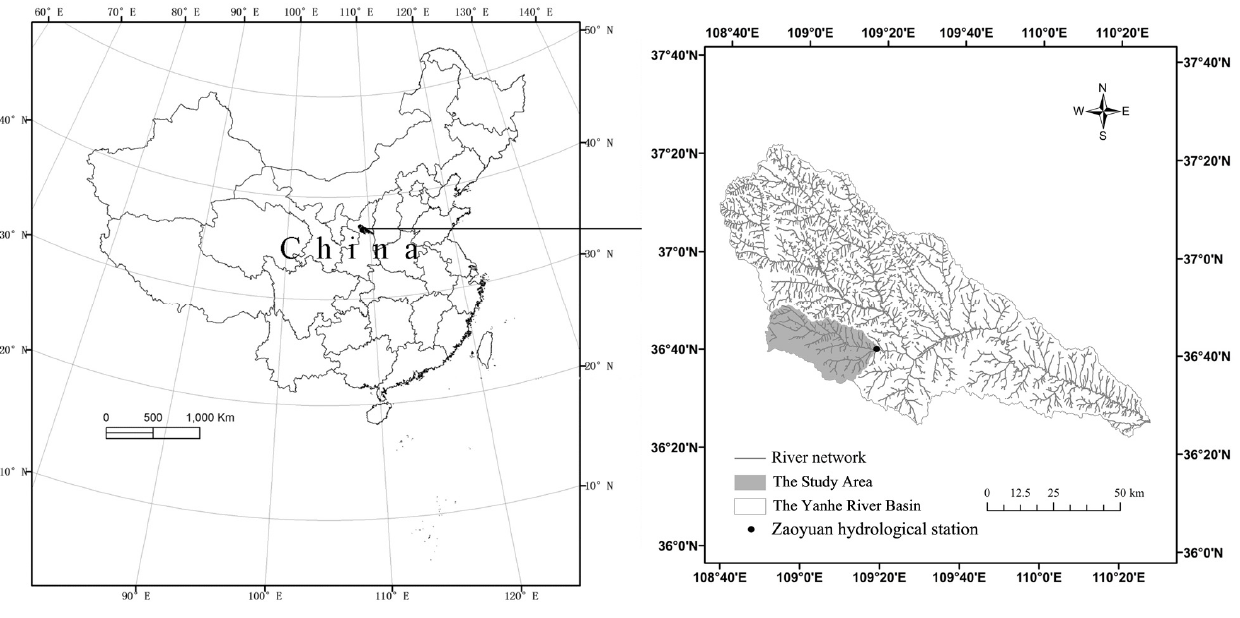
Figure 2. Location of the study area.